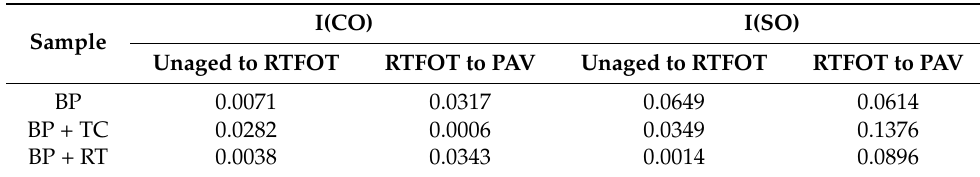
Table 4. Oxidation evolution with ageing stages.